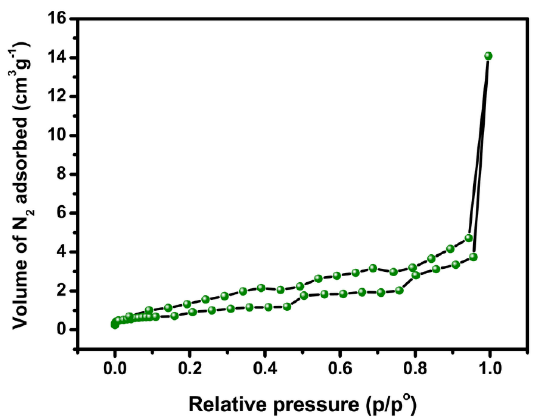
Figure 2. N 2 -adsorption and desorption isotherm of SrNiO 3 perovskite catalyst.